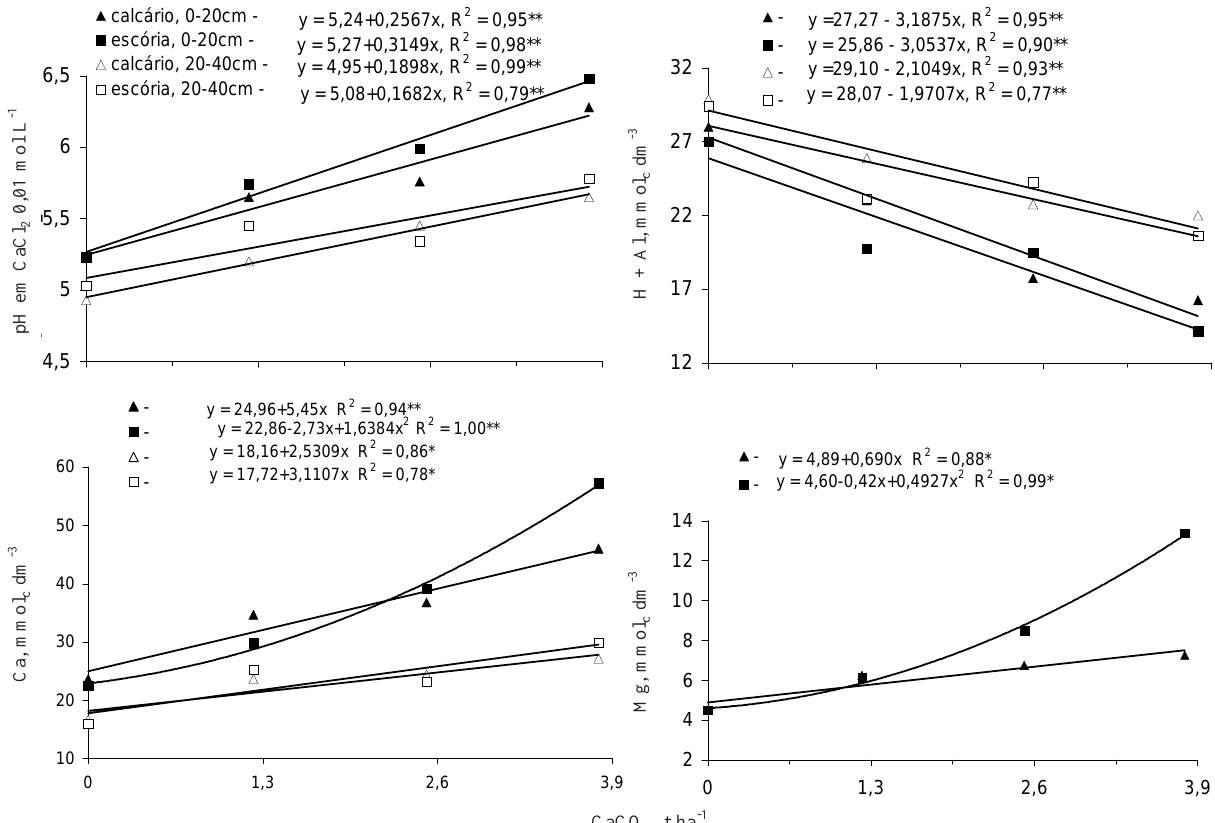
Figura 2. Efeito do calcário e da escória de siderurgia no valor de pH, nos teores de Ca, Mg e (H + Al) de um Latossolo Vermelho-Amarelo cultivado com cana-de-açúcar. (Dados médios de duas épocas de amostragem e quatro